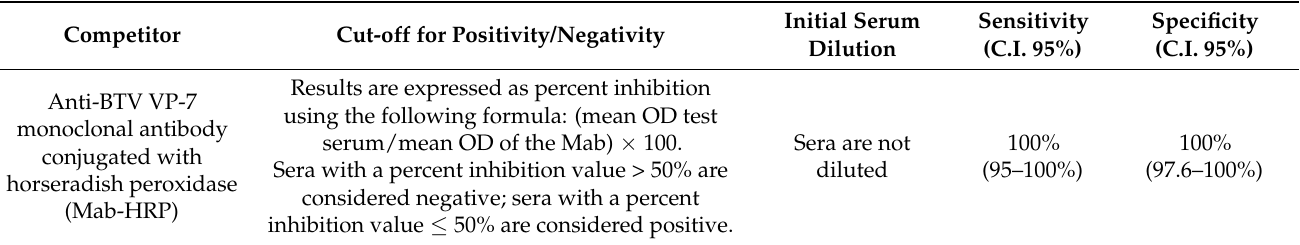
Table 1. Details of the in-house competitive ELISA used in the